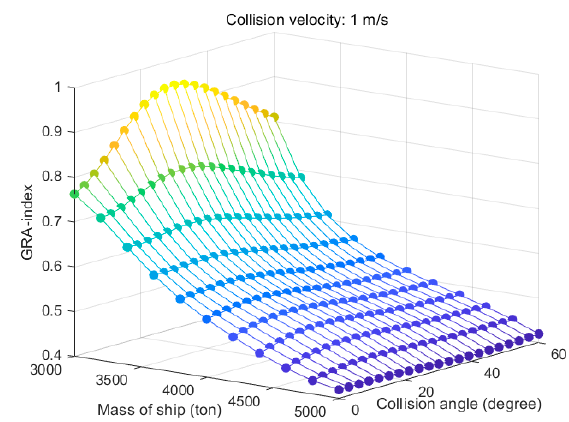
Figure 11. GRA index with regard to collision angle and mass of ship.